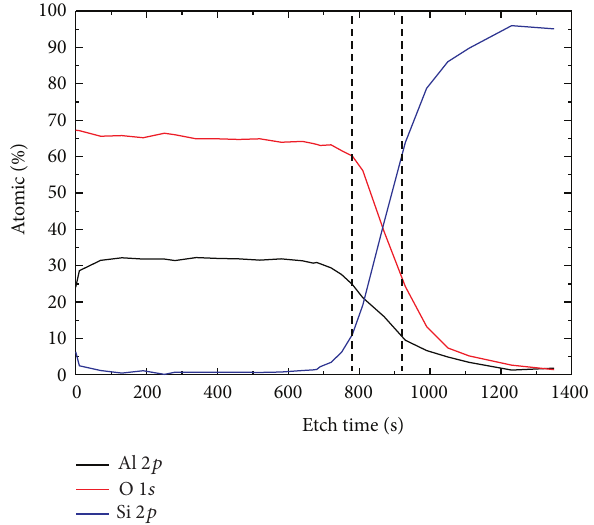
verticaldashedlinesmarktheapproximatelocationoftheinterfacial